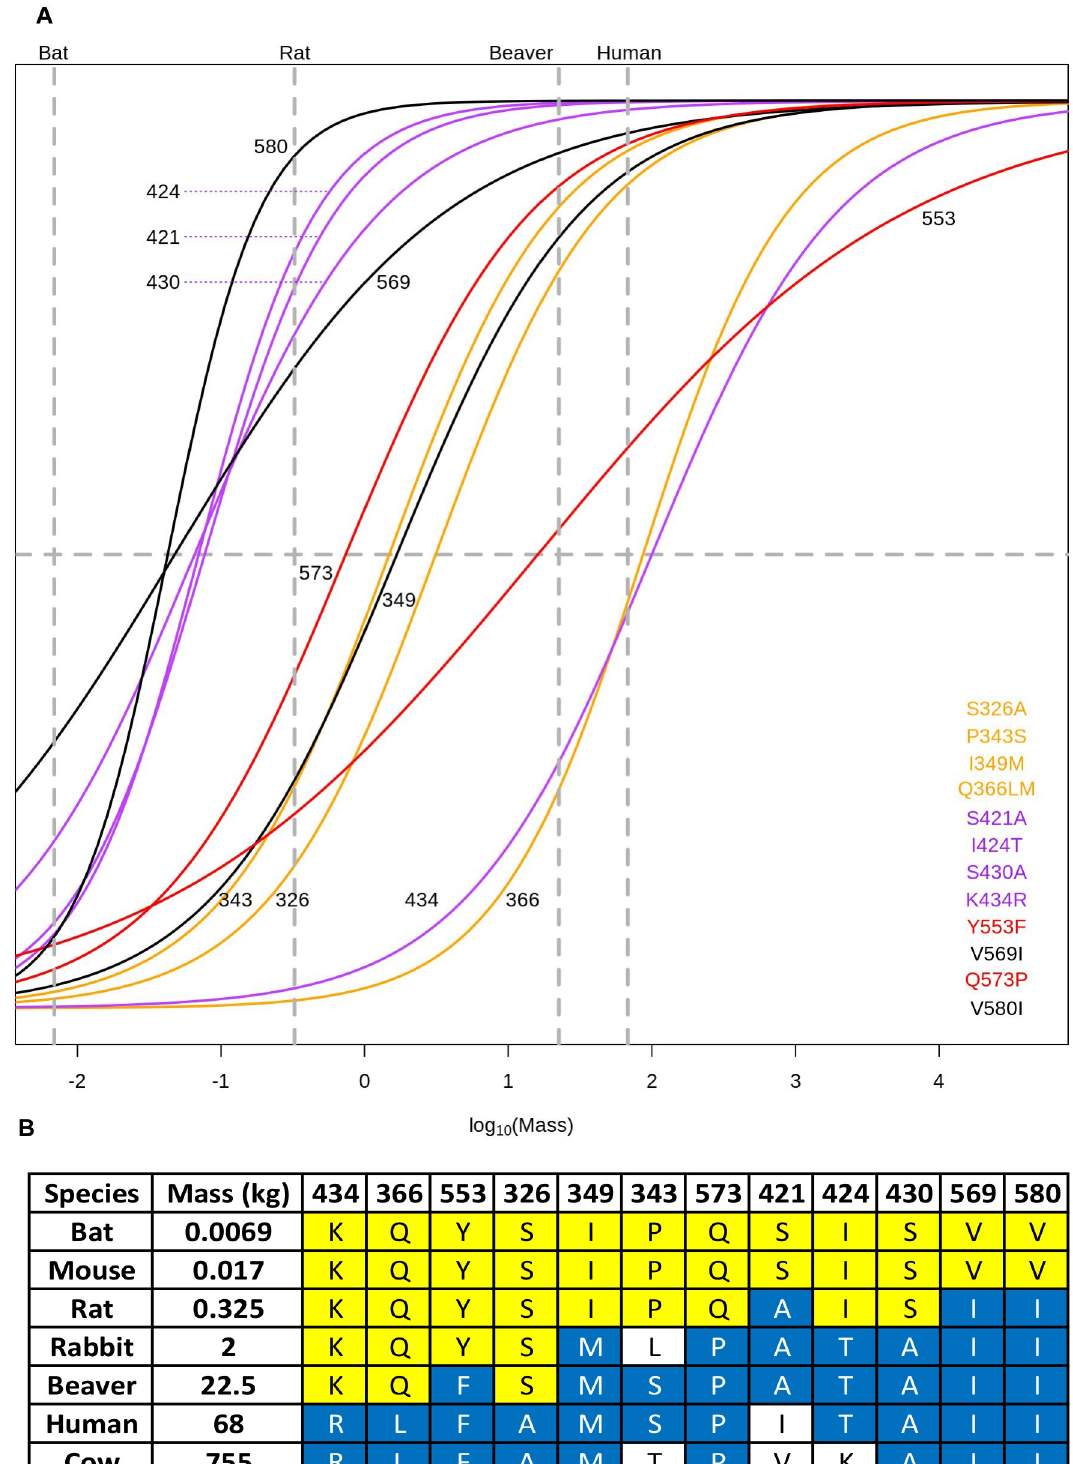
Fig 6. Residue mass transition plots. Overlapping binomial regression mapping the transition of the most frequent amino acid at positions in the motor region of β -myosin to the second most frequent amino acid at that position for the 12 residues of interest. The 3 groups of residues investigated are highlighted and labelled in orange (326, 343, and 366), purple (421, 424, 430, and 434), and red (553 and 573) in each plot. The residues in black are residues of interest, but were not mutated (349, 569, and 580). The table shows